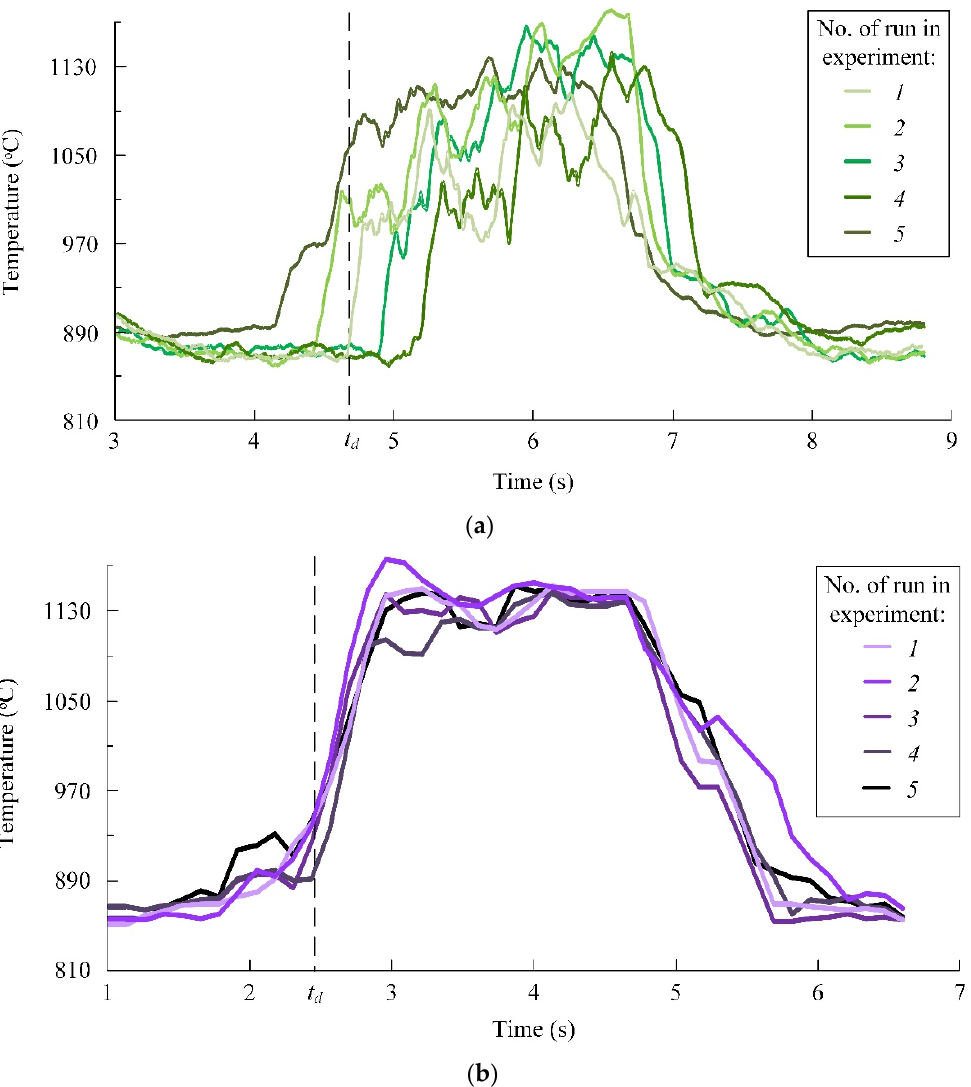
Figure 20. Flame temperature during the combustion of gel fuel at T g = 850 °C: ( a ) No. 1 and ( b ) No. 2; 1–5 —number of run in a series of experiments.